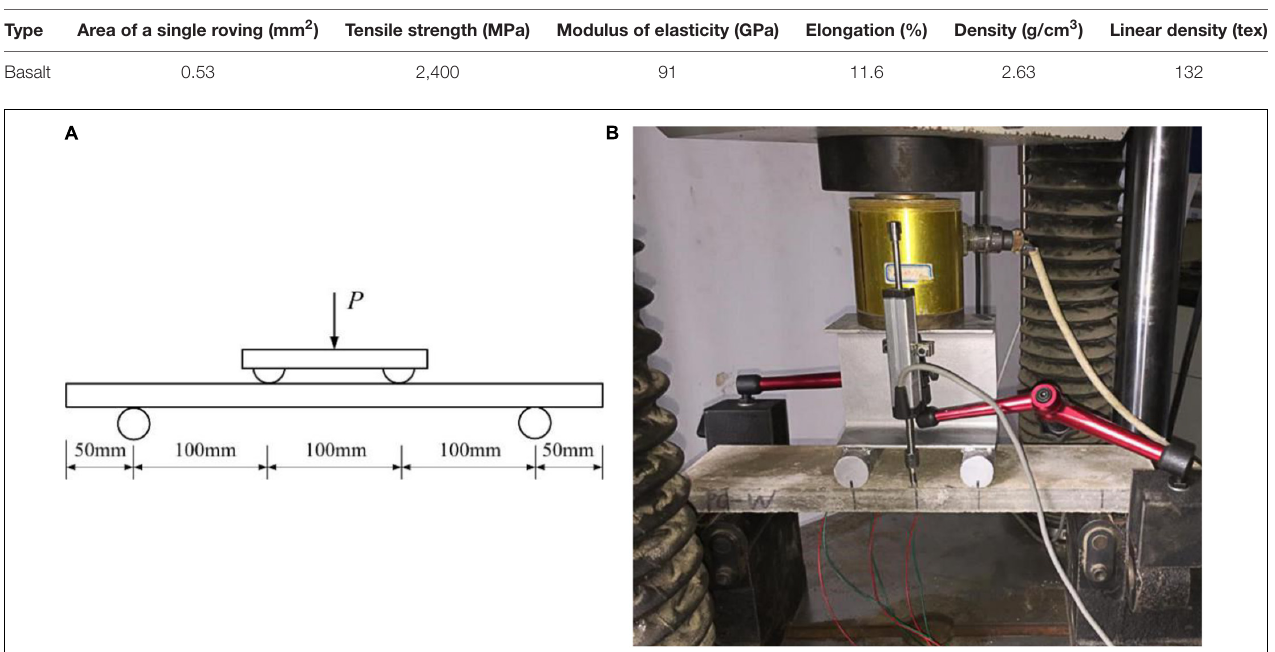
TABLE 4 | Physical and mechanical properties of basalt textile.